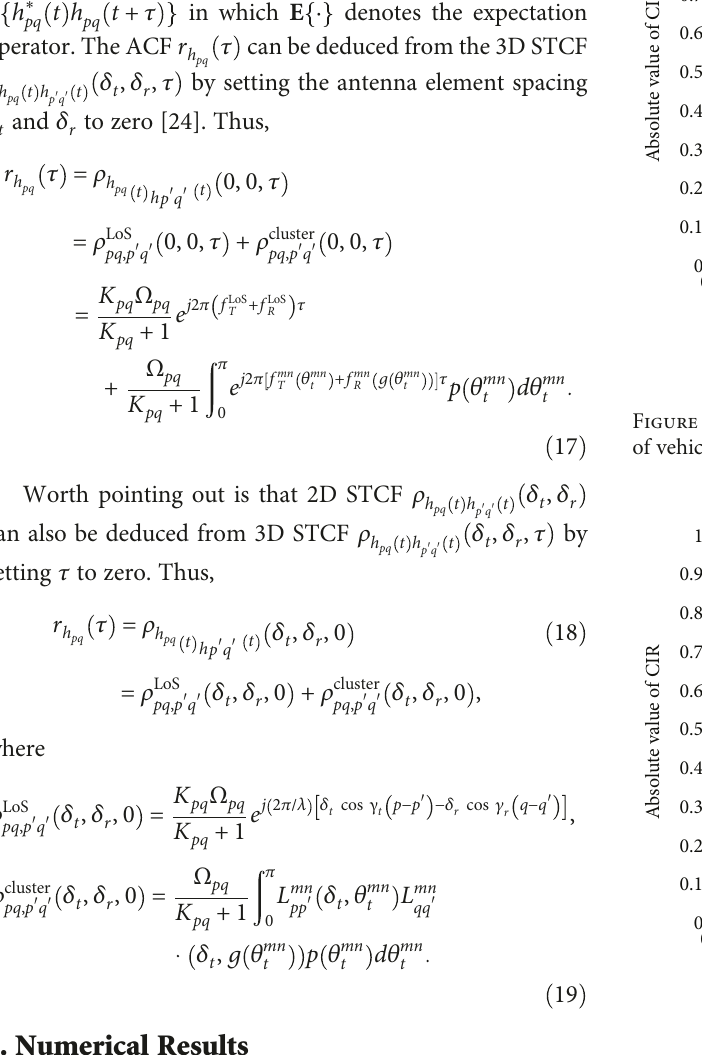
Figure 5: Power-delay pro fi le of the channel for high moving speed of vehicles (Tx/Rx): v